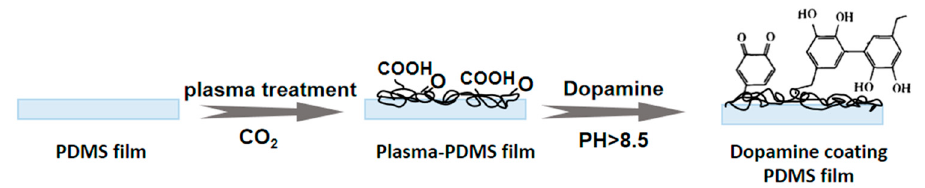
Figure 1. Schematic diagram of experimental reaction process.